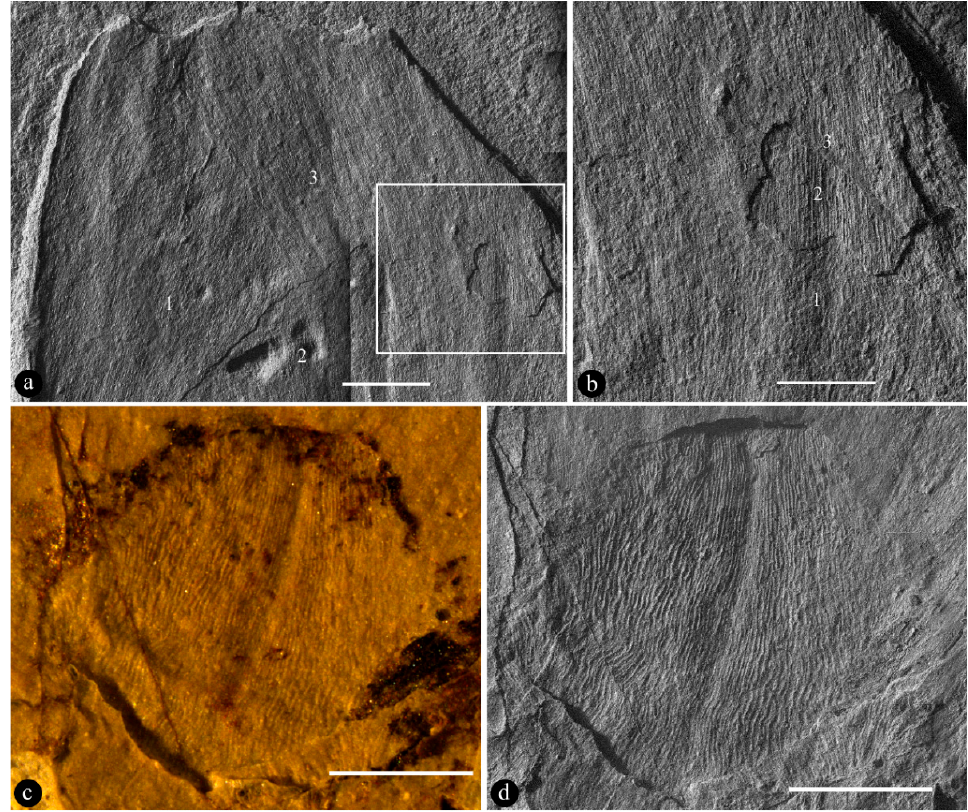
Figure 3. Details of Archaebuda gen. nov under SEM, except Figure 3c. ( a ) Detailed view of the tip of the flower bud, showing at least three overlapping papery foliar appendages of type II (1,2, 3, corresponding to d, c, b in Figure 2c) with differently oriented textures. Bar = 1 mm. ( b ) Detailed view of the rectangle in Figure 3a, showing three layers of overlapping papery foliar appendages of type II (1, 2, 3). SEM. Bar = 0.5 mm. ( c ) Stereomicroscopic view of a keeled foliar appendage of type I at the base of the flower bud. Bar = 1 mm. ( d ) SEM image of the foliar appendage of type I shown in Figure 3c, showing surface texture. Bar = 1